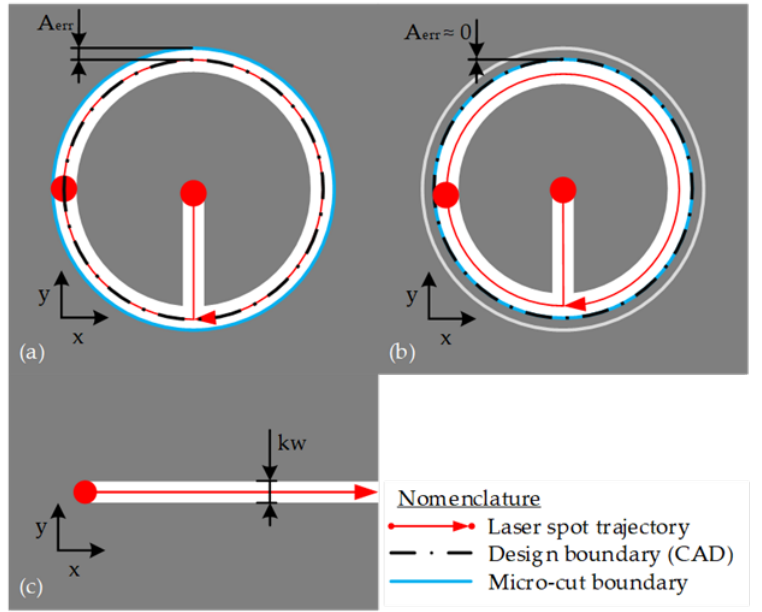
Figure 1. Laser micro-cutting trajectory ( a ) without kerf width compensation and ( b ) with kerf width compensation, and ( c ) kerf width (kw) measurement.